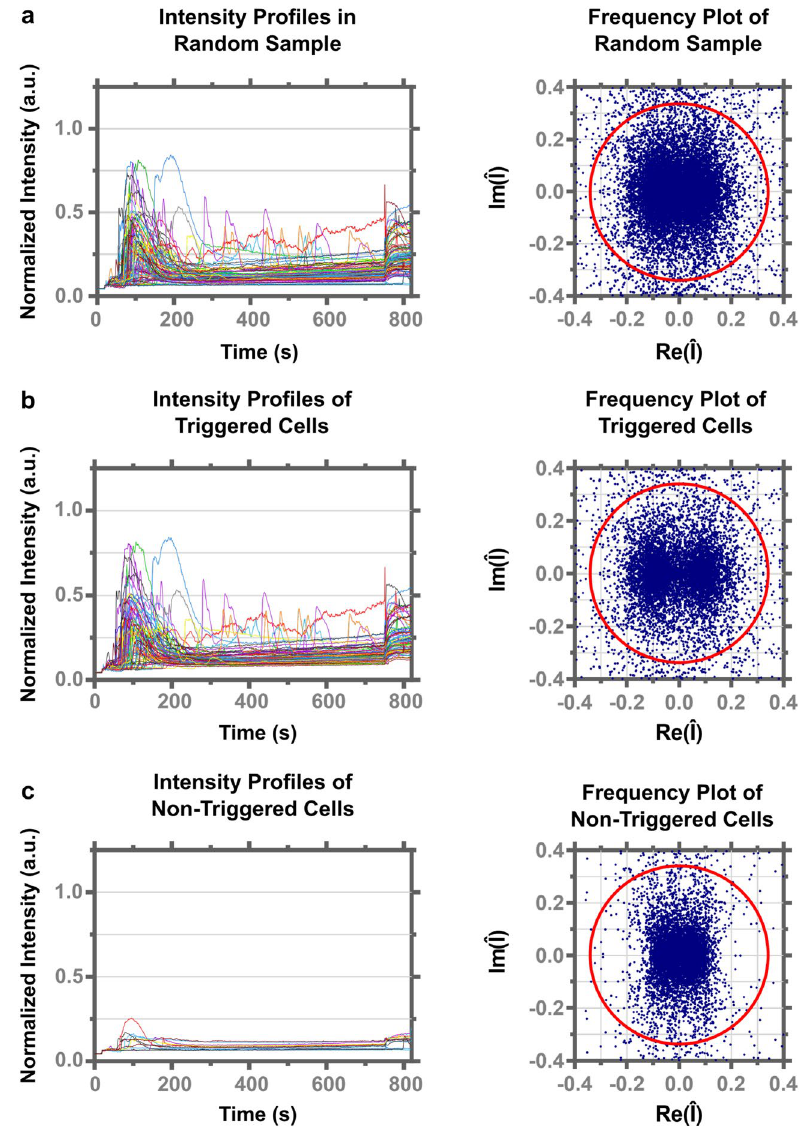
Figure 2. Example plots of normalized Ca 2 + intensities over time (left) and Fourier transformed Ca 2 + responses (right) in 1G4-TCR T cells that came into contact with a 9V:MHC functionalized coverslip. ( a ) Representative random sample of the triggering and non-triggering cells. ( b ) Cells of the random sample that CalQuo 2 regards as triggering. ( c ) Cells of the random sample that CalQuo 2 regards as non-triggering. The Triggering radius of 0.34 is depicted as the red circle in the frequency